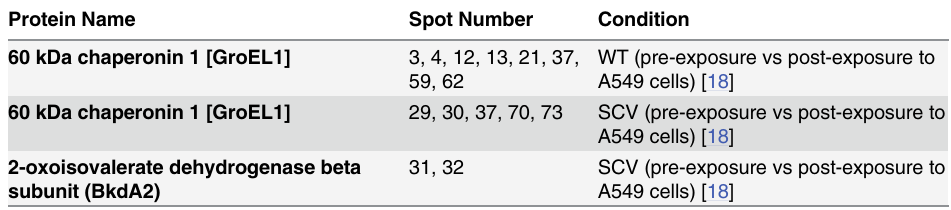
Table 3. Identical protein spots of Burkholderia pseudomallei colony morphovariants among different conditions. Protein